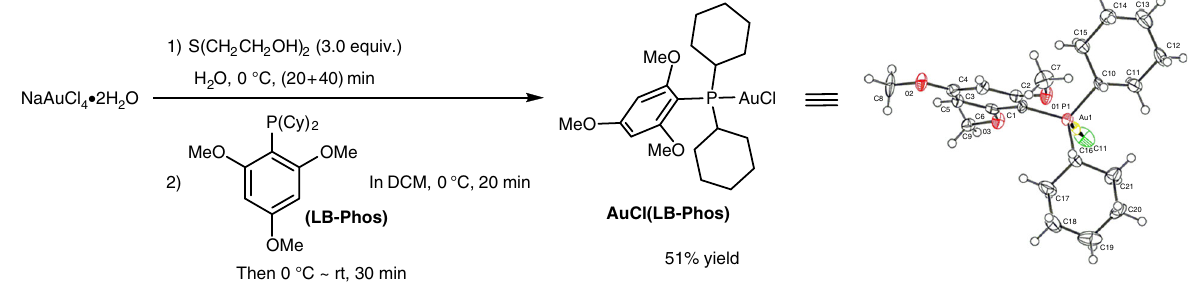
Fig. 3 Complex AuCl(LB-Phos). Synthesis and ORTEP representation of AuCl(LB-Phos)